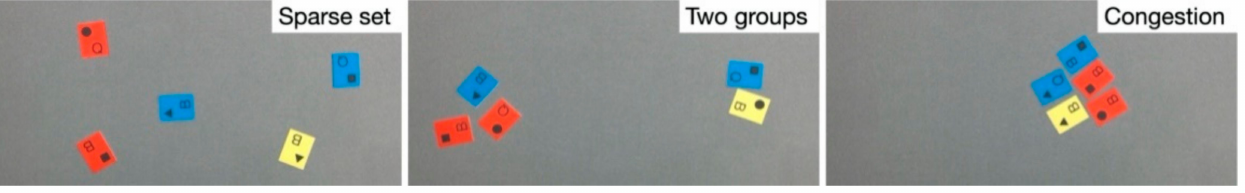
Figure 10. Example of book arrangements by a participant.